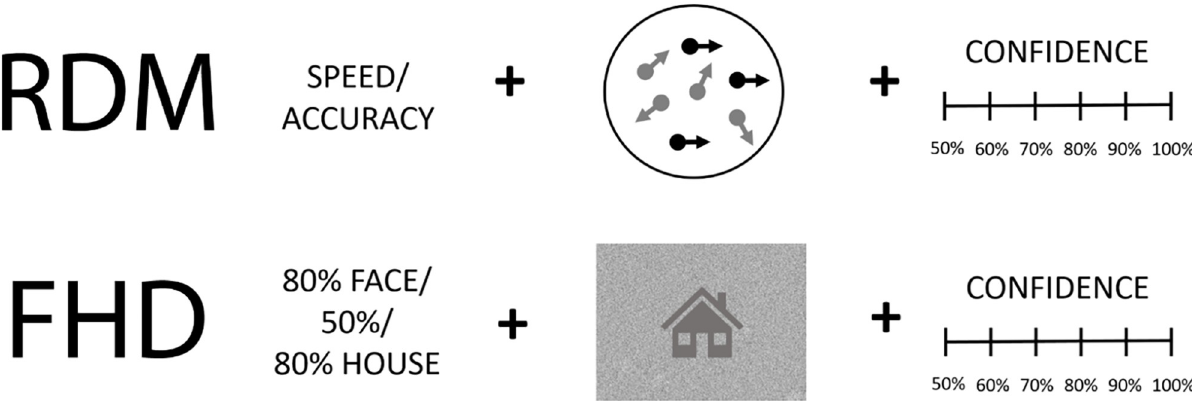
Fig 1. Experiment 1 task design. Upper row: random-dot motion (RDM) task. Lower row: face/house discrimination (FHD) task.